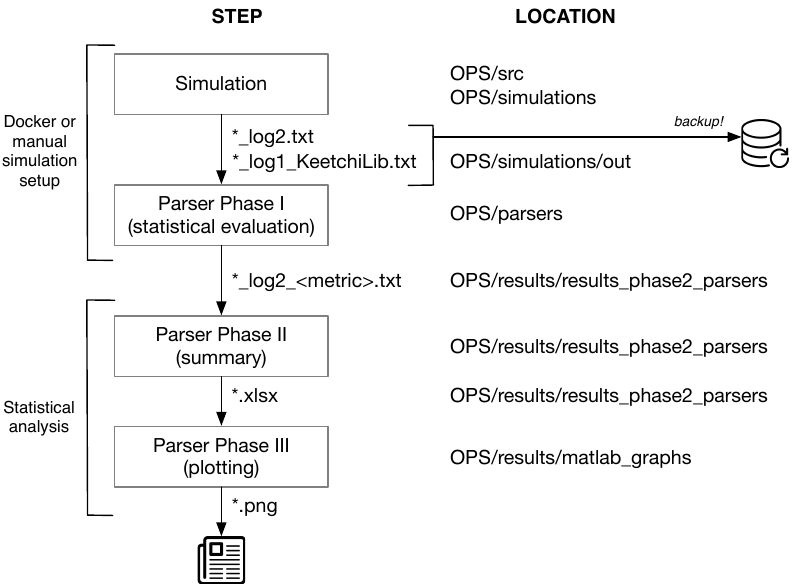
Figure A3. An overview of our simulation and evaluation